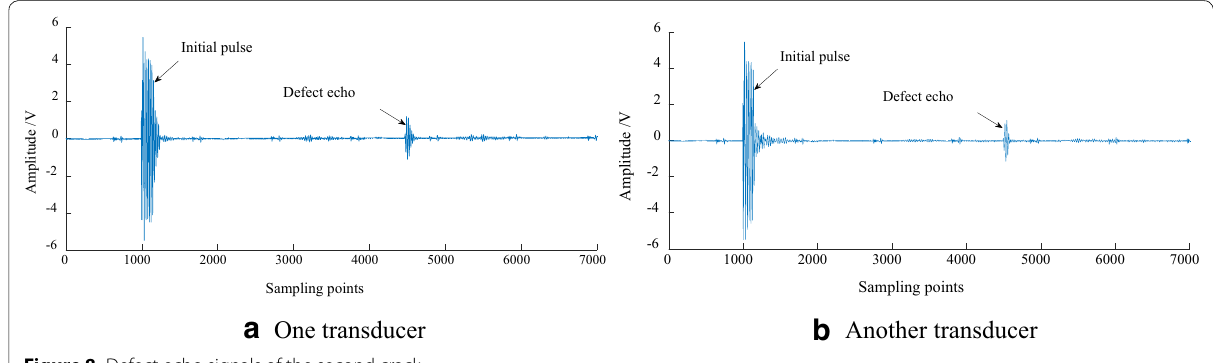
Figure 8 Defect echo signals of the second